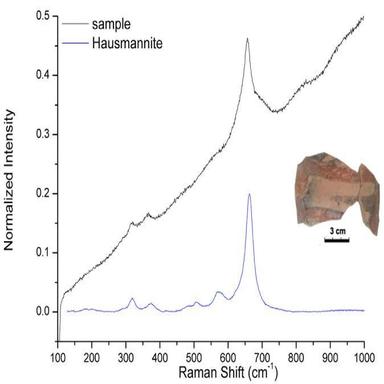
Comparison between Raman spectrum obtained in the black decoration (black) and a reference hausmannite spectrum (taken from the RRUFF™ Project website database (http://rruff.info/)ff.info/)) (blue) (sample Pip.6 from the Pipistrelli cave - Matera). (For interpretation of the references to color in this figure legend, the reader is referred to the web version of this article.)